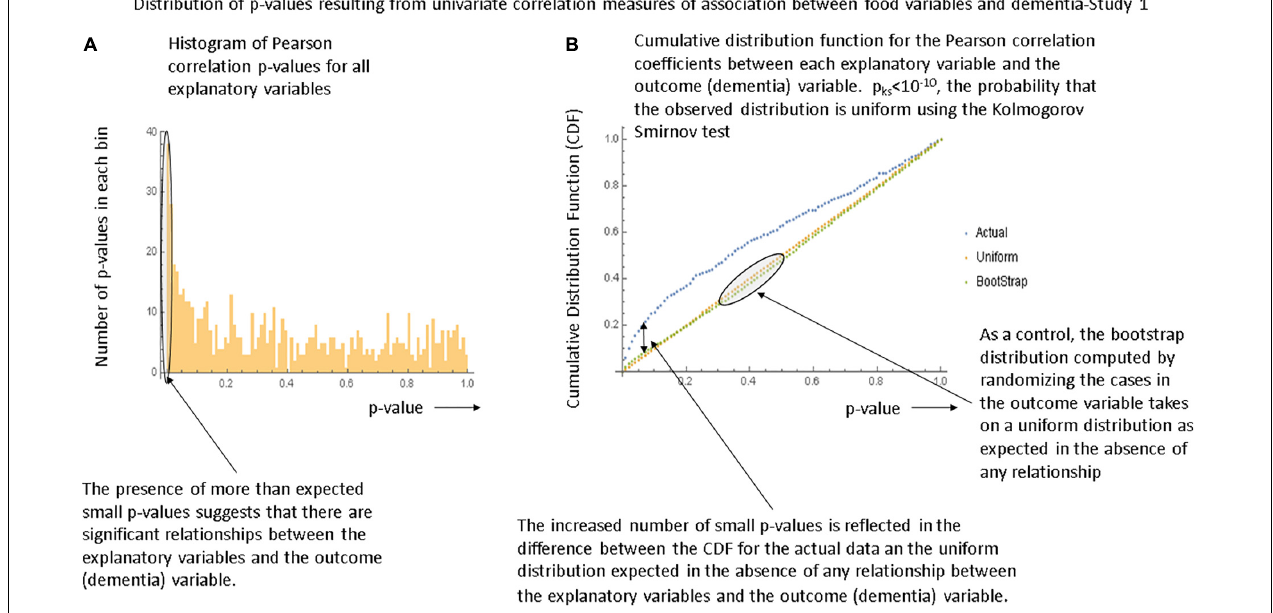
FIGURE 1 | Illustration of the global tests for significance in the first study. (A) Histogram of the p -values generated by the Pearson correlation tests between each food variable and dementia in the first study. (B) The cumulative density function (CDF) describing the p -values. The bootstrap distribution is that derived by randomizing the dementia variable values and is linear as expected. The Kolmogorov-Smirnov test demonstrates that the observed distribution is unlikely to be uniform and hence that there is a significant relationship between the explanatory variables and the outcome variable.